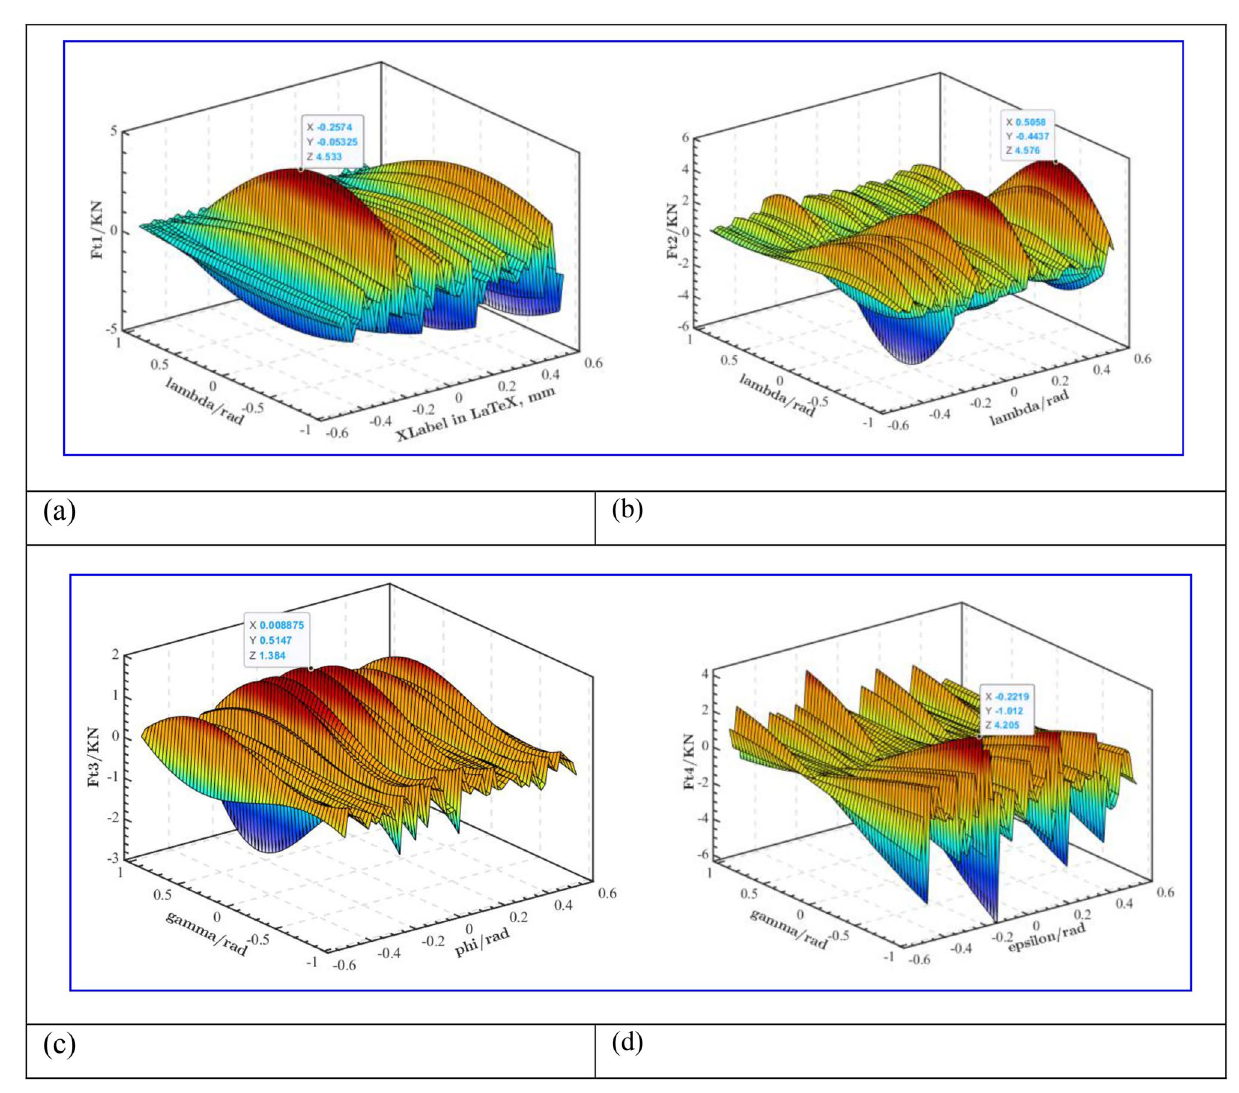
Figure 6. Diagram of support force changing with support angle (inward legs): ( a ) F t1 variation with Support Angle; ( b ) F t2 variation with Support Angle; ( c ) F t3 variation with Support Angle; ( d ) F t4 variation with Support